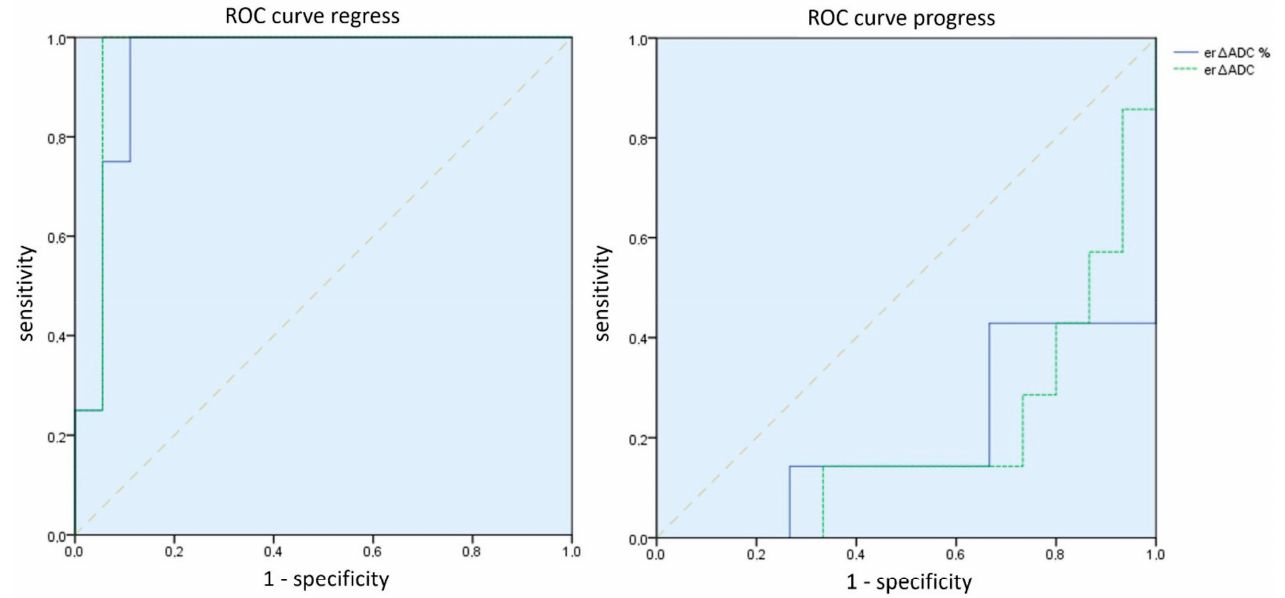
Figure 7. ROC curves of the absolute (green) and percentage (blue) er ∆ ADC values for regress and progress prediction. It is shown that both an ADC decrease as a parameter in tumor progression and, in particular, an ADC increase as a parameter in tumor regression have a high ability to discriminate.